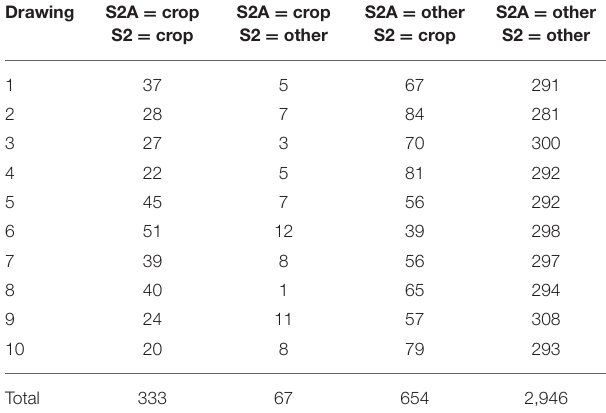
TABLE 2 | Query results for Center Sahel.